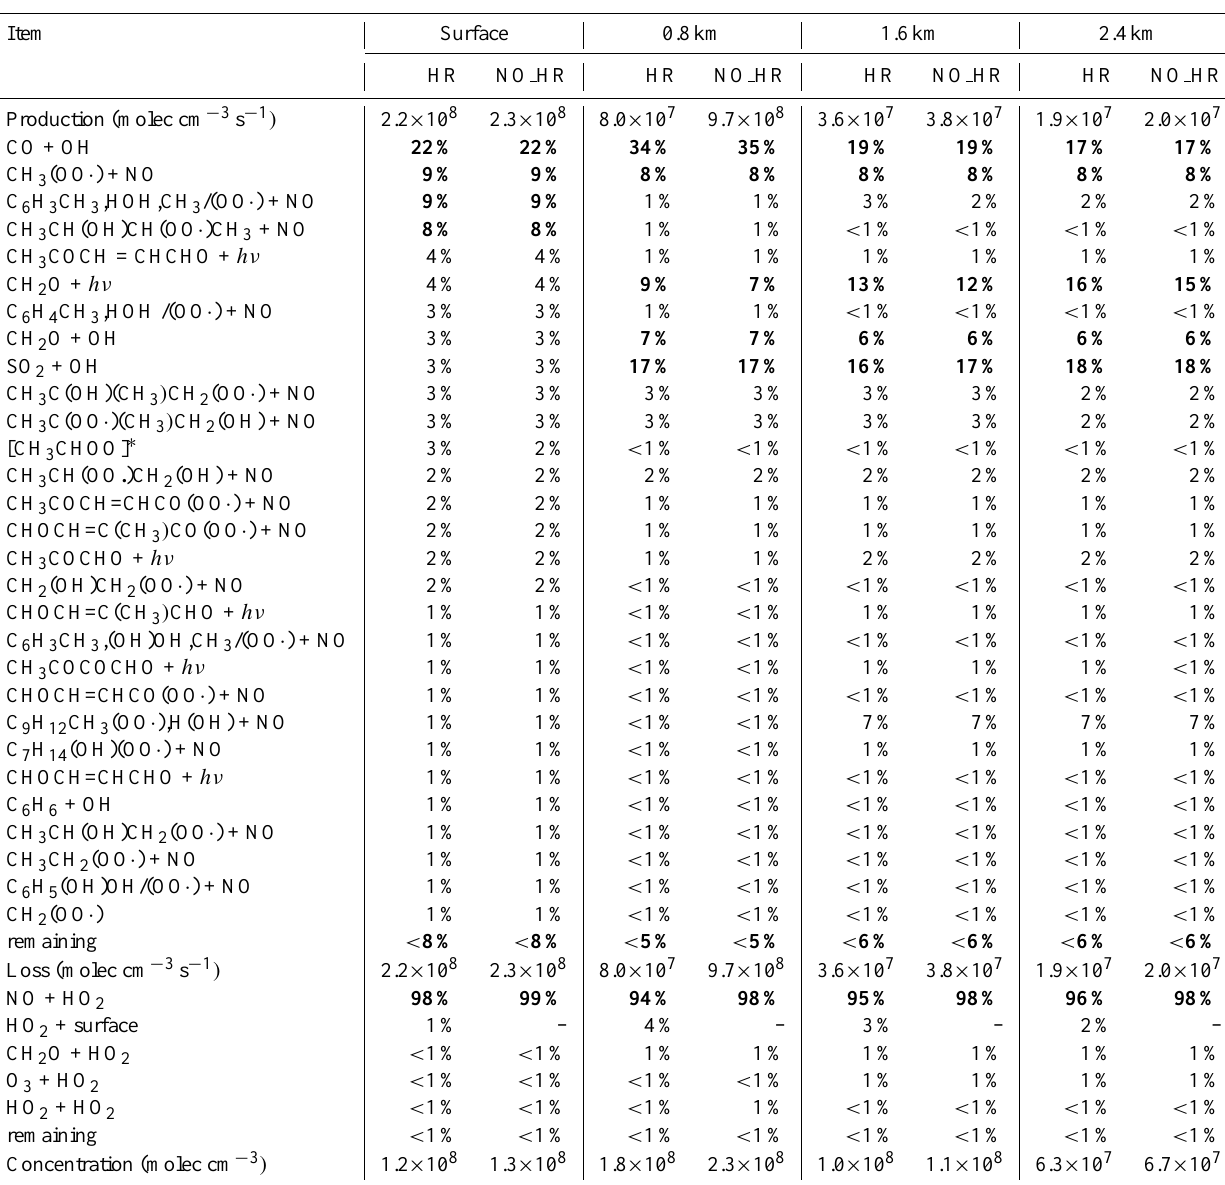
Table 5. HO 2 budget at different altitudes based on a model analysis of measurement data with and without considering heterogeneous reactions (HR) of OH and HO 2 on aerosol